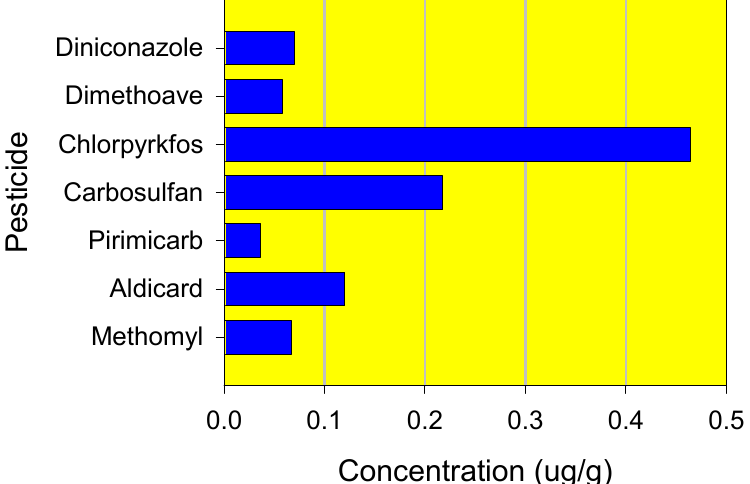
Figure 3. Maximum concentrations of pesticide residues detected in soil